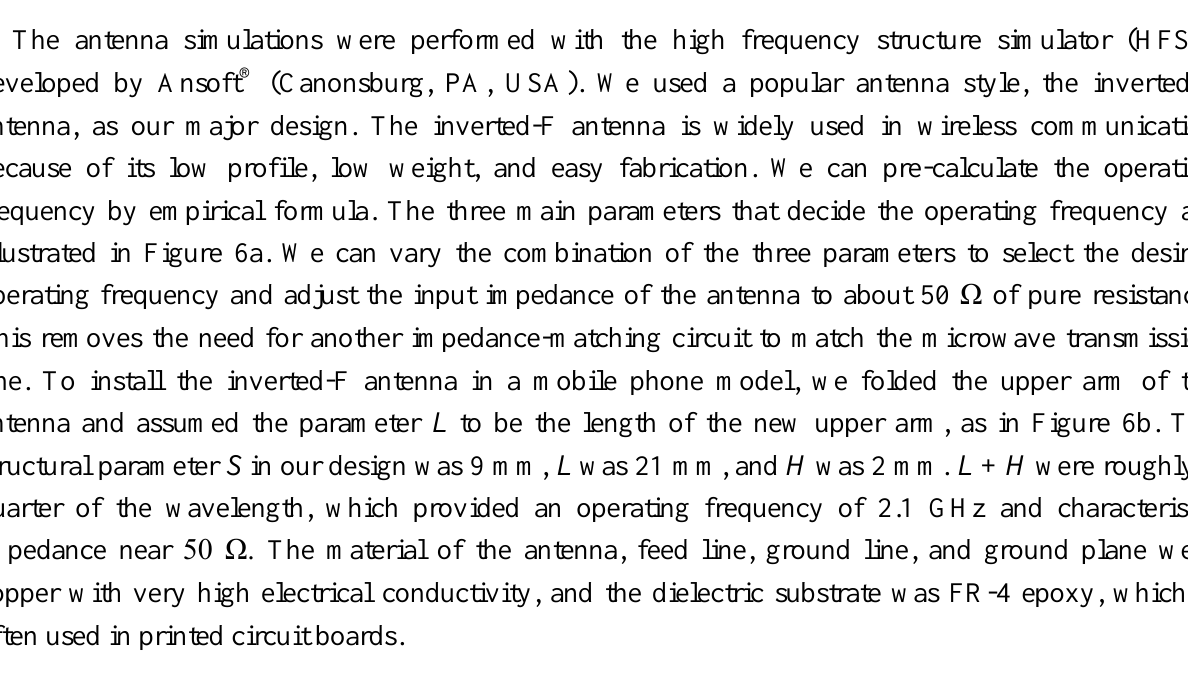
Figure 6. ( a ) Structure of inverted-F antenna; and ( b ) Simulation layout with substrate